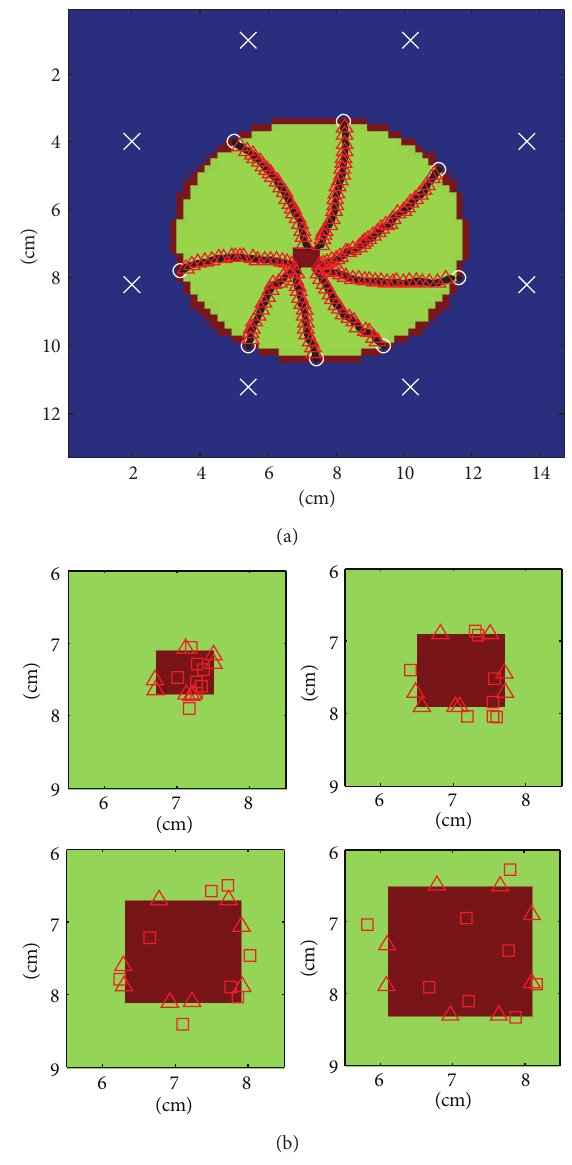
Figure 7: (a) Multidirectional tumor targeting. (b) Simulated DMI footprints for four tumors with different sizes. The actual and estimated final MTB footprints are marked with “ 󳵻 ” and “ ◻ ”,